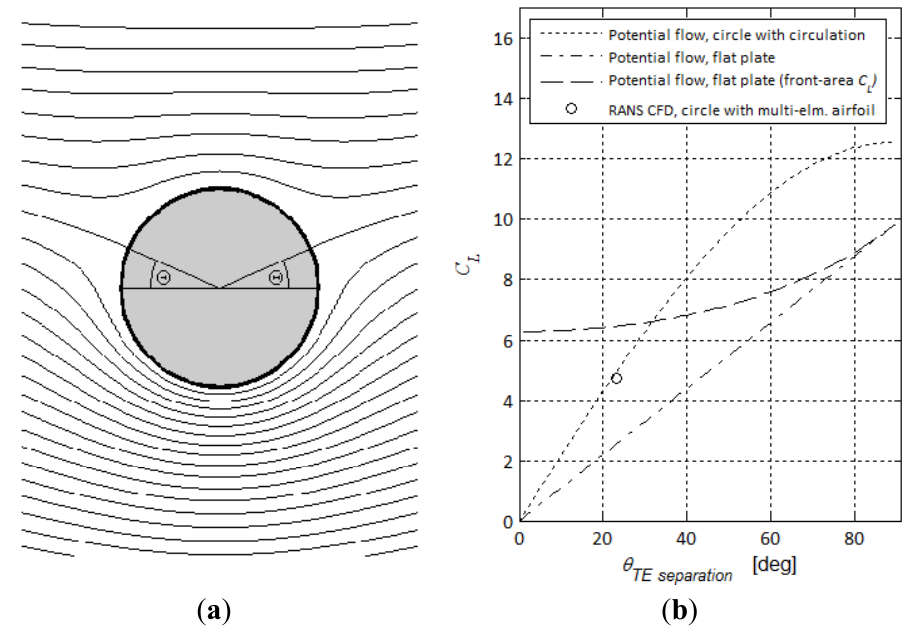
Figure 6. ( a ) Potential flow past a circular cylinder with circulation; ( b ) Lift coefficients for varying θ for the circular cylinder and the flat plate according to Equations (28)–(30).